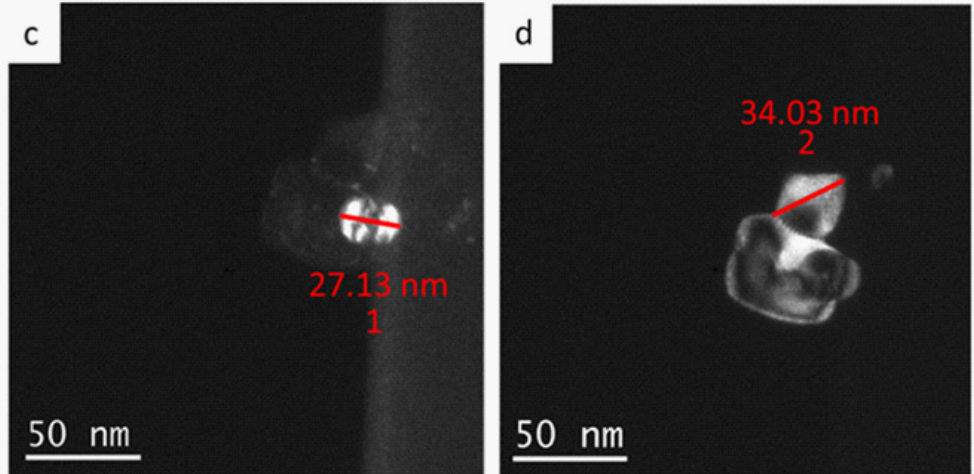
Figure 11. ( a ) TEM bright-field image of the co-formed ternary aggregate of three nanoparticles: 10Cu–80Ni–10Co and the corresponding selected area diffraction ( b ). The single reflection marked as 1 in this pattern generated the dark field image of the single nanoparticle of ( c ) and the double reflection marked as 2 generated the dark field mage of the two nanoparticles image of ( d ) (reduction at 300 ◦ C/10